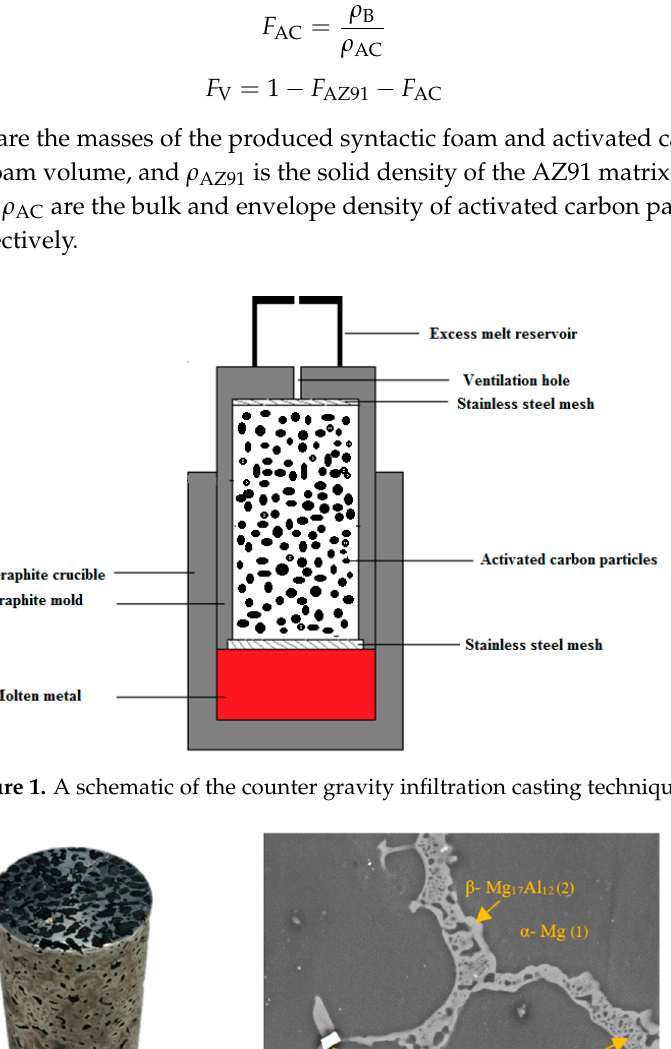
Figure 1. A schematic of the counter gravity infiltration casting technique.